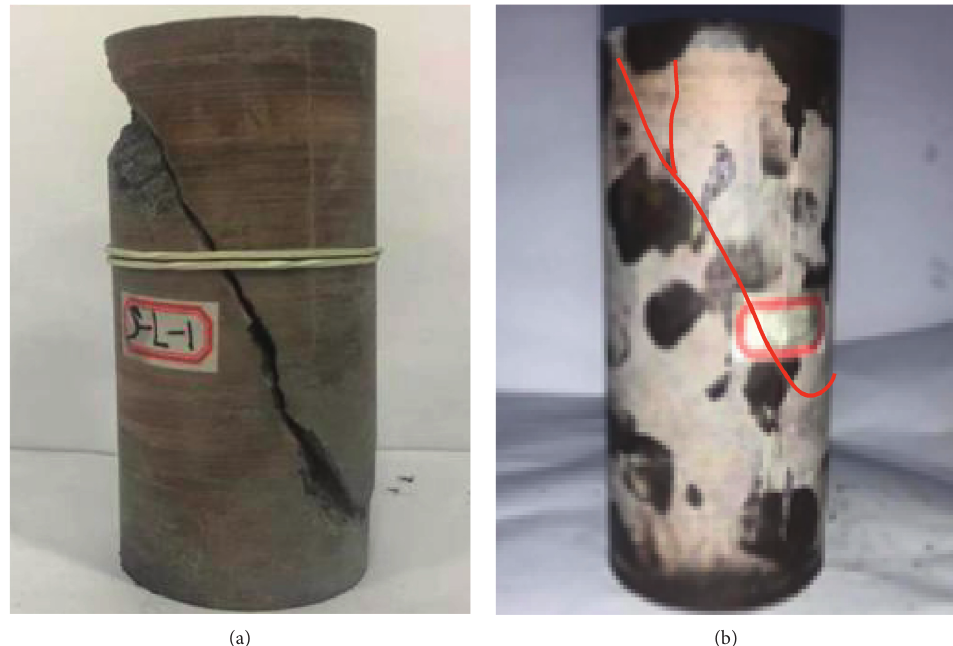
Figure 10: Failure morphology of mudstone in triaxial rheological test. (a) Unloading confining pressure with constant axial pressure. (b) Unloading confining pressure with axial compression.